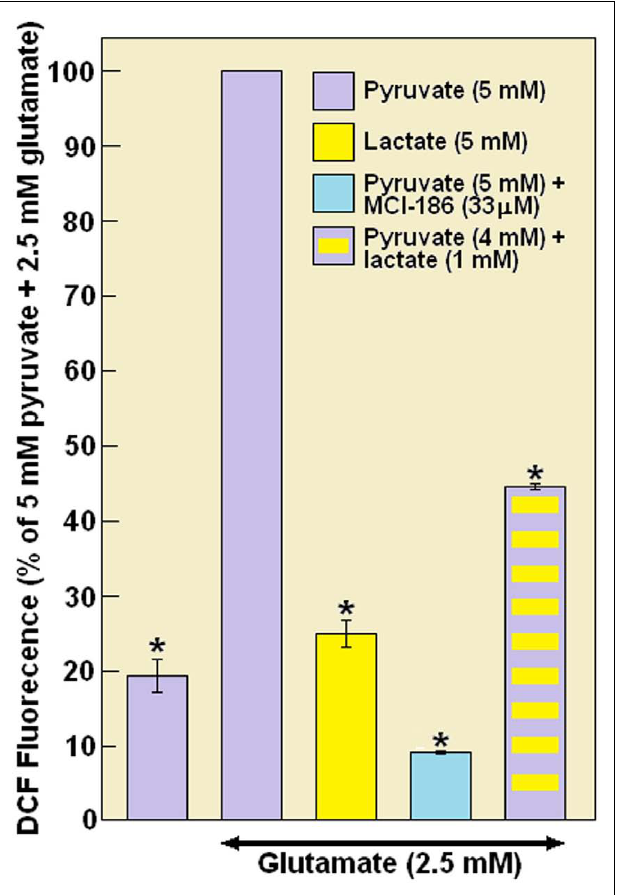
FIGURE 10 |The level of reactive oxygen species (ROS) as measured using the fluorescence of dichlorofluorescein (DCF) extracted from slices perfused with aCSF containing glutamate (2.5mM) and either pyruvate (5mM), lactate (5mM), the combination of [pyruvate (4mM) + lactate (1mM)], or the combination of [pyruvate (5mM) + MCI-186 (33 μ M)] (see details in Materials and Methods). Also shown is a set of experiments in which Glut was omitted from the aCSF of pyruvate-supplemented slices. Glut-treated, lactate-, or MCI-186-supplemented slices exhibited significantly lower levels of ROS than pyruvate-supplemented, Glut-treated slices. Each sample for measurement of fluorescence used five slices and was prepared in duplicates. Measurements were repeated at least three times. Bars are SE of the mean. *Significantly different from pyruvate + Glut ( p <